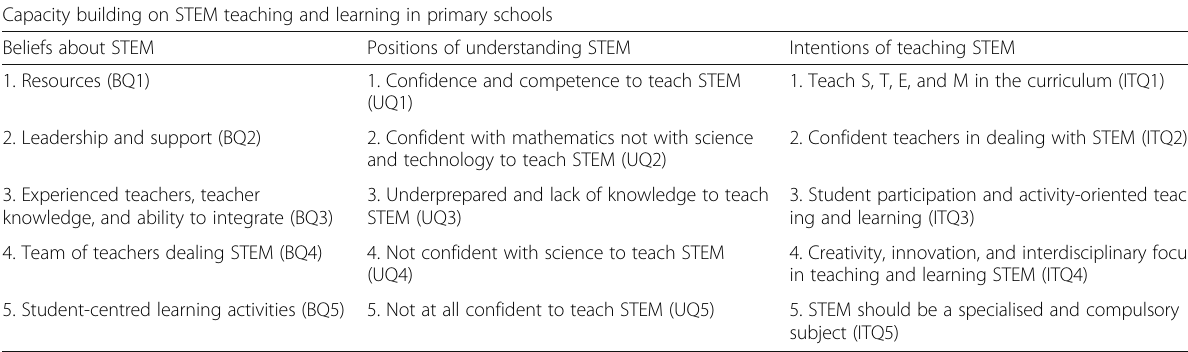
Table 1 Aspects of capacity building regarding STEM generated from qualitative responses Capacity building on STEM teaching and learning in primary schools Beliefs about STEM Positions of understanding STEM Intentions of teaching